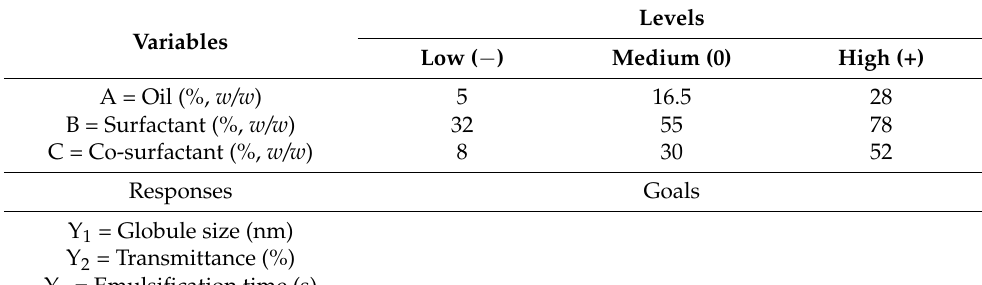
Table 1. Formulation variables and their responses used to optimize CEP